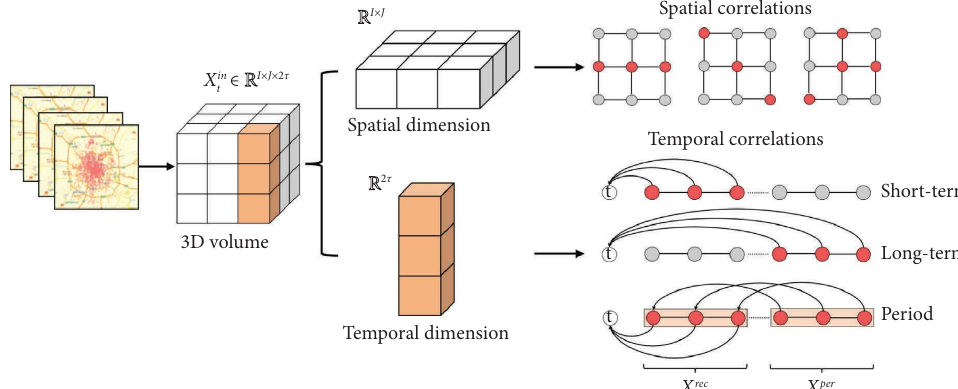
Figure 2: Te 3D volume constructed to describe the spatial and temporal information of demand data.